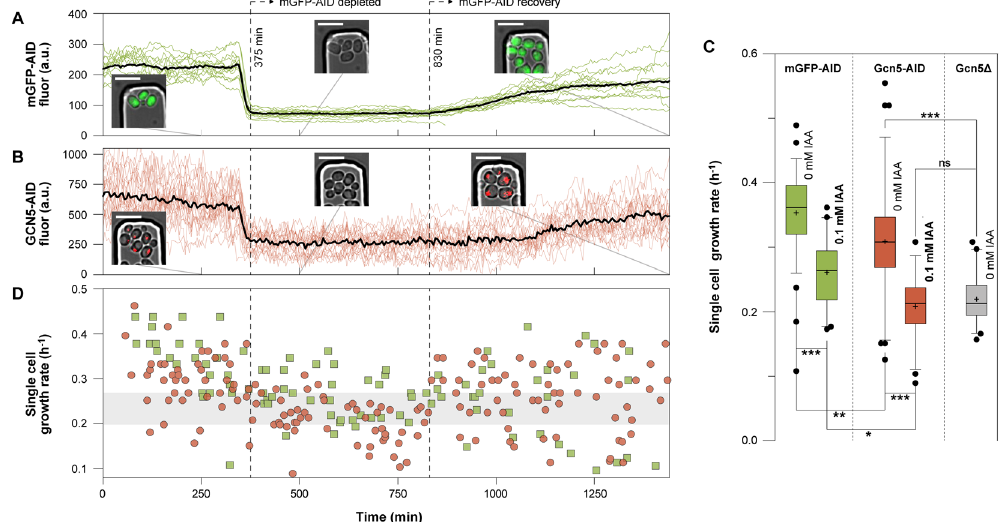
Figure 4. The auxin-induced growth defects can be discriminated from the growth-related Gcn5 depletion phenotype. ( A ) Control cells expressing mGFP-AID were mixed with ( B ) cells expressing Gcn5-mCherry-AID and grown in the same microfluidic device on 10 gL − 1 glucose. Upon the addition of auxin (0.1 mM), mGFP- AID and the nuclear Gcn5-mCherry-AID were depleted at the same time (375 min). The recovery dynamics of the two proteins after auxin removal (at 830 min) are also visible. The black trajectories correspond to the average mGFP-AID (14 cells) and Gcn5-mCherry-AID (23 cells) signals. The colored trajectories correspond to the single cell signals. Microscopy images confirm the localization and levels of the fluorescent proteins (scale 10 μ m) ( C ) The single cell growth rates in the absence (0 mM IAA) and after the addition (0.1 mM IAA) of auxin, of mGFP-AID (green boxes), Gcn5-mCherry-AID (red boxes) and Gcn5 Δ cells (grey boxes) growin in minimal medium with high (10 gL − 1 ) glucose (error bars: 5–95 percentile, cross: mean). From left to right: 79 budding cycles from 34 cells, 40 from 14, 76 from 41, 52 from 23, 40 from 17 single cells. (Kruskal-Wallis test, Dunns post-test to compare all pairs of data, p < 0.001 *** , p < 0.01 ** , p < 0.05 * , p > 0.05 ns). ( D ) The single cell growth rates at different time points are plotted for each yeast strain (green squares: mGFP-AID, red circles: